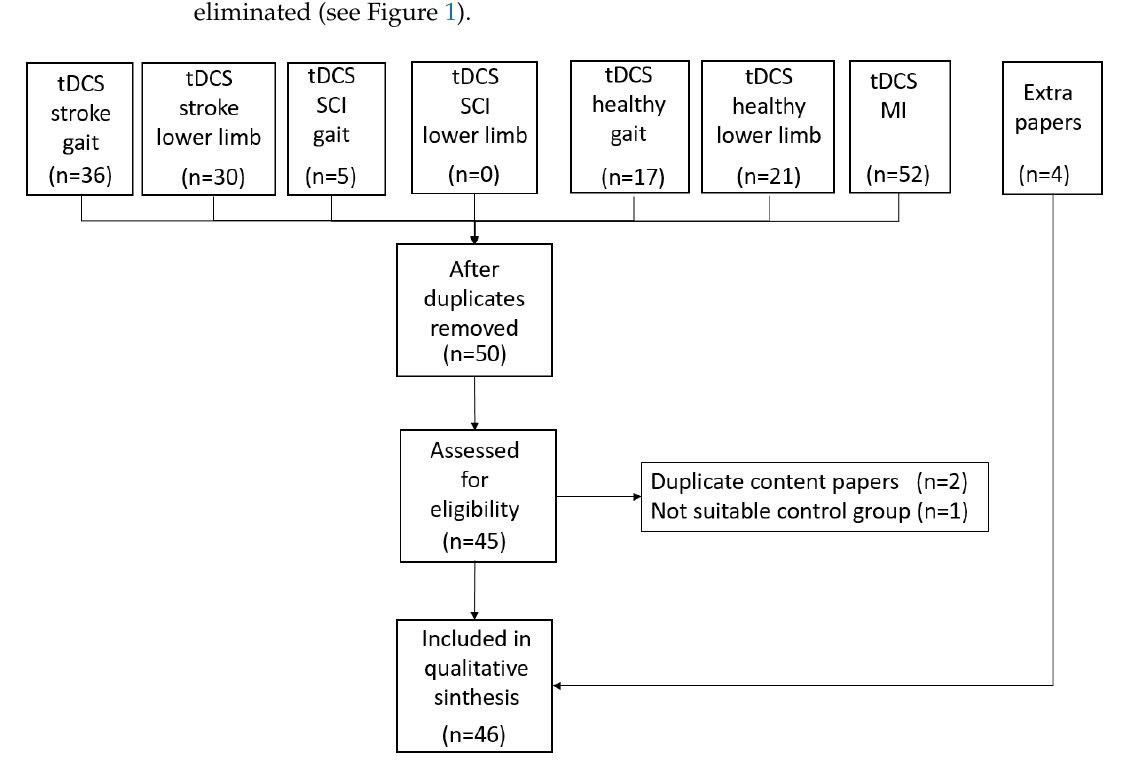
Figure 1. Of the 161 papers found, only 50 passed the inclusion criteria. After eliminating duplicates, only 45 papers were analyzed in the eligibility phase. Three of them were discarded due to being papers published in reduced versions or papers with control groups that did not meet the inclusion criteria. Four additional papers were added due to their relevance and because they were cited in other works. A total of 46 papers were finally included in the final